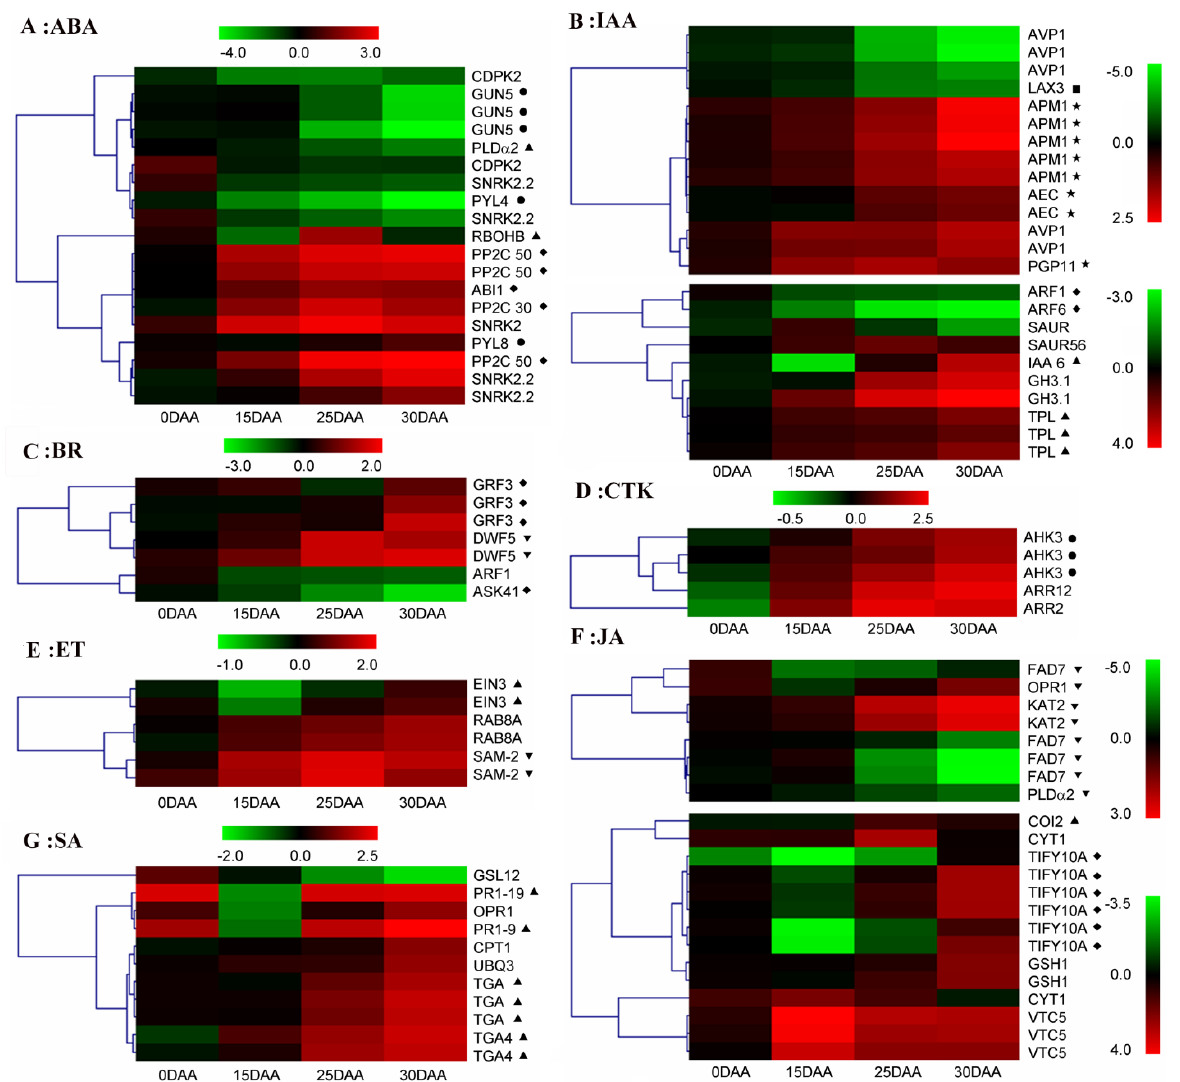
Figure 5. Cluster analysis of phytohormone-related DEGs. ( A ) ABA. ( B ) IAA. ( C ) BR. ( D ) CTK. ( E ) ET. ( F ) JA. ( G ) SA. “ • ”: Phytohormone receptor, “ (cid:78) ”: Positive regulator, “